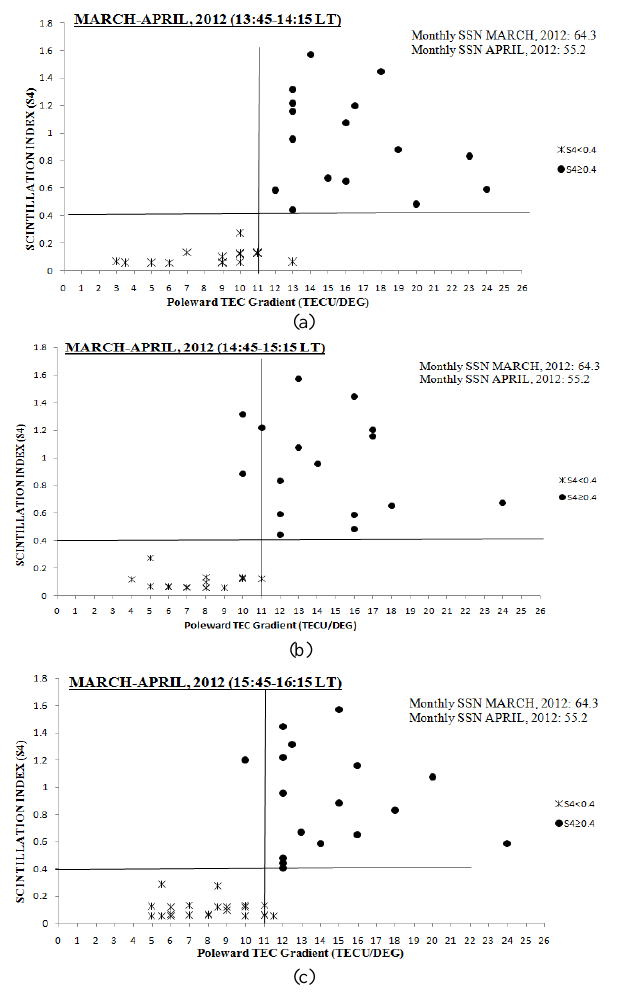
Figure 6 Fig. 6. (a–c) Correlation of poleward gradient of EIA calculated at 14:00, 15:00 and 16:00LT, respectively, over subionospheric lati- tude 24 ◦ –27 ◦ N and longitude swath 88.5 ◦ E on different days of